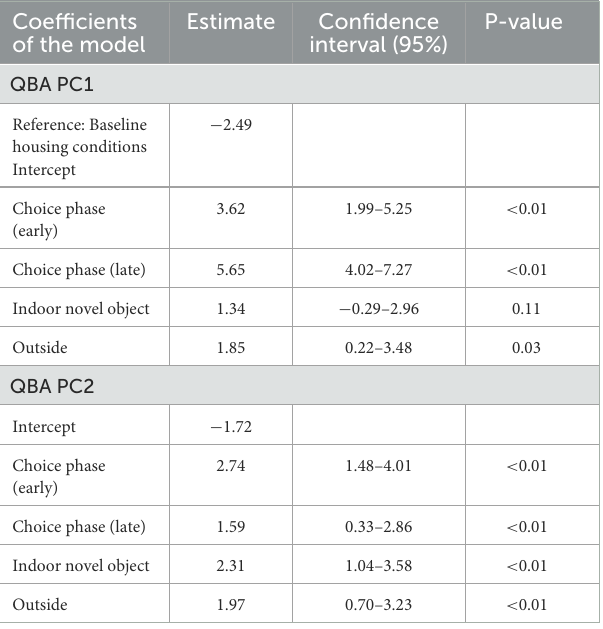
TABLE 6 Group 1 and 2 combined: Results of the linear model assessing PC1 and PC2 scores attained during the different treatment periods. Coefficients of the